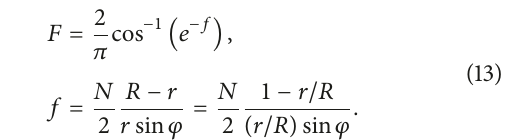
Table 2: Values of activation overpotential constants [11]. Cathode